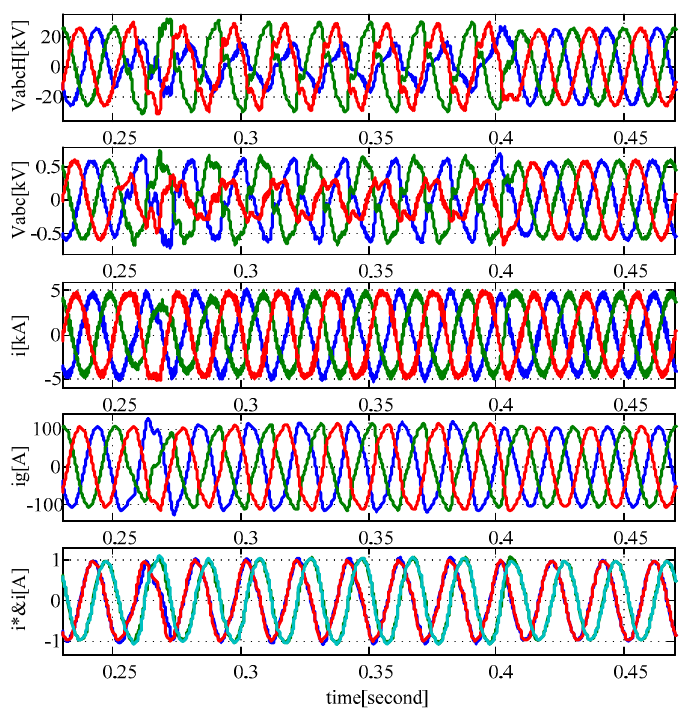
Figure 20. Set points of active and reactive currents in positive sequence in case of 1ph 100% voltage sag without injecting negative sequence current.